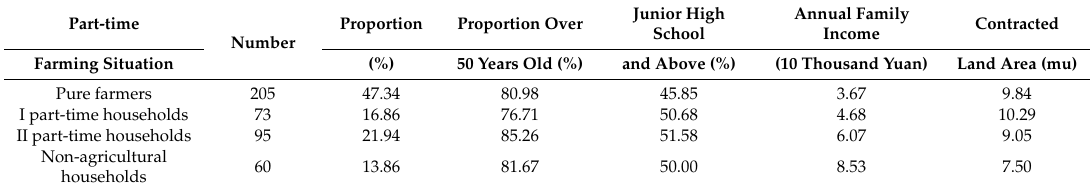
Table 3. Socio and economic situation of di ff erent types of part-time